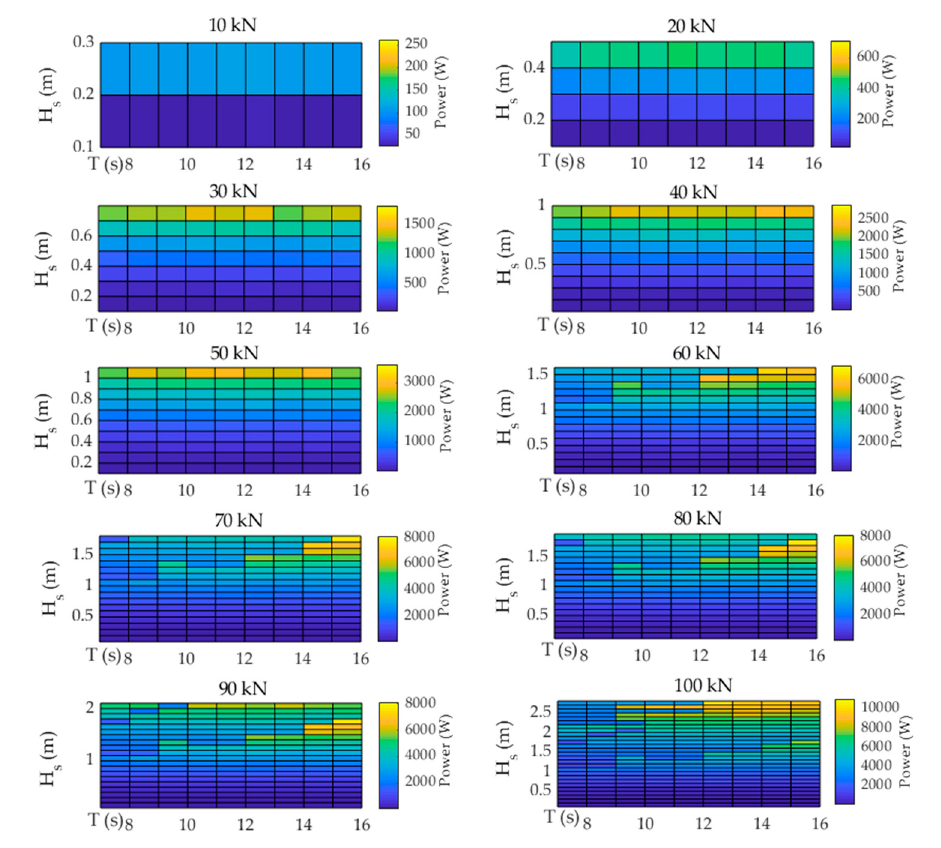
Figure 11. MCFL Figure 11. MCFL matrix.